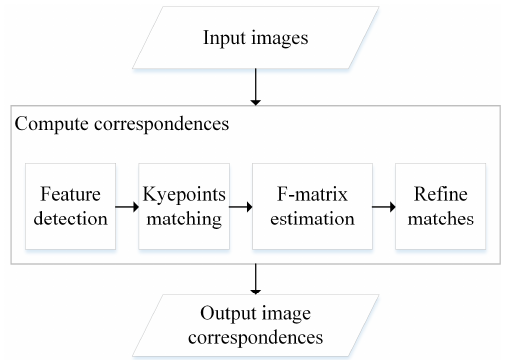
Figure 2. The process of computing image correspondences As Figure 3 shows, we first selected good image pair to derive an initial reconstruction. This image pair should have enough matching points. The five-Point algorithm (Nister, 2004) was used to estimate the extrinsic parameters of the matching pair, and the 3D points of initial model can be obtained after the triangulation process. Then we iteratively added new images and calculated its 3D points. The newly obtained 3D points were fused with the previously calculated 3D points. Through the multi-view projective SfM process, the extrinsic parameters of cameras are obtained and the 3D point cloud of the simulated asteroid was reconstructed.